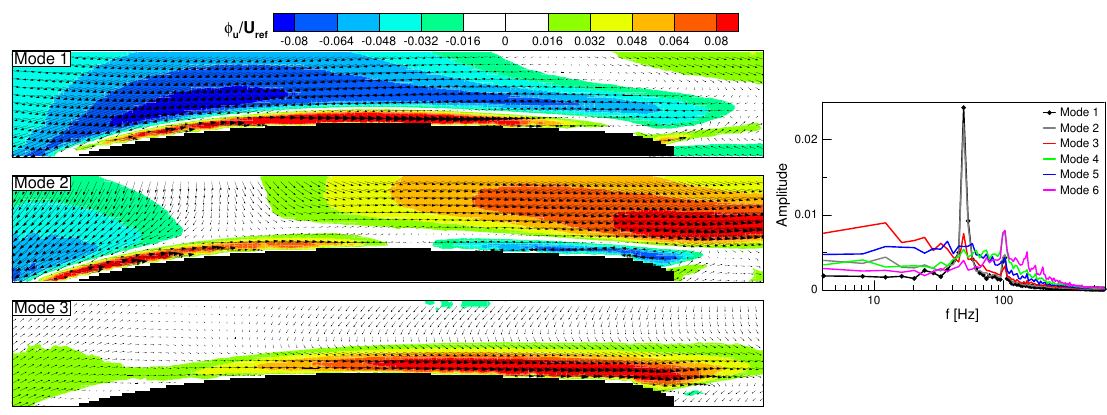
Figure 5. The proper orthogonal decomposition (POD) modes (left) and Fourier spectra of POD eigenvectors (right) for the nominal f +